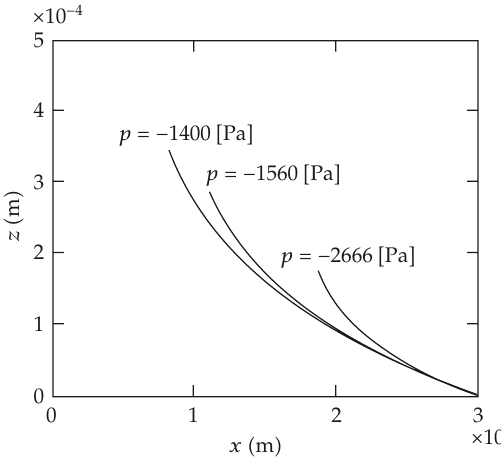
Figure 2: z versus x for p (cid:8) − 2666; − 1560; − 1400 (cid:6) Pa (cid:7) .